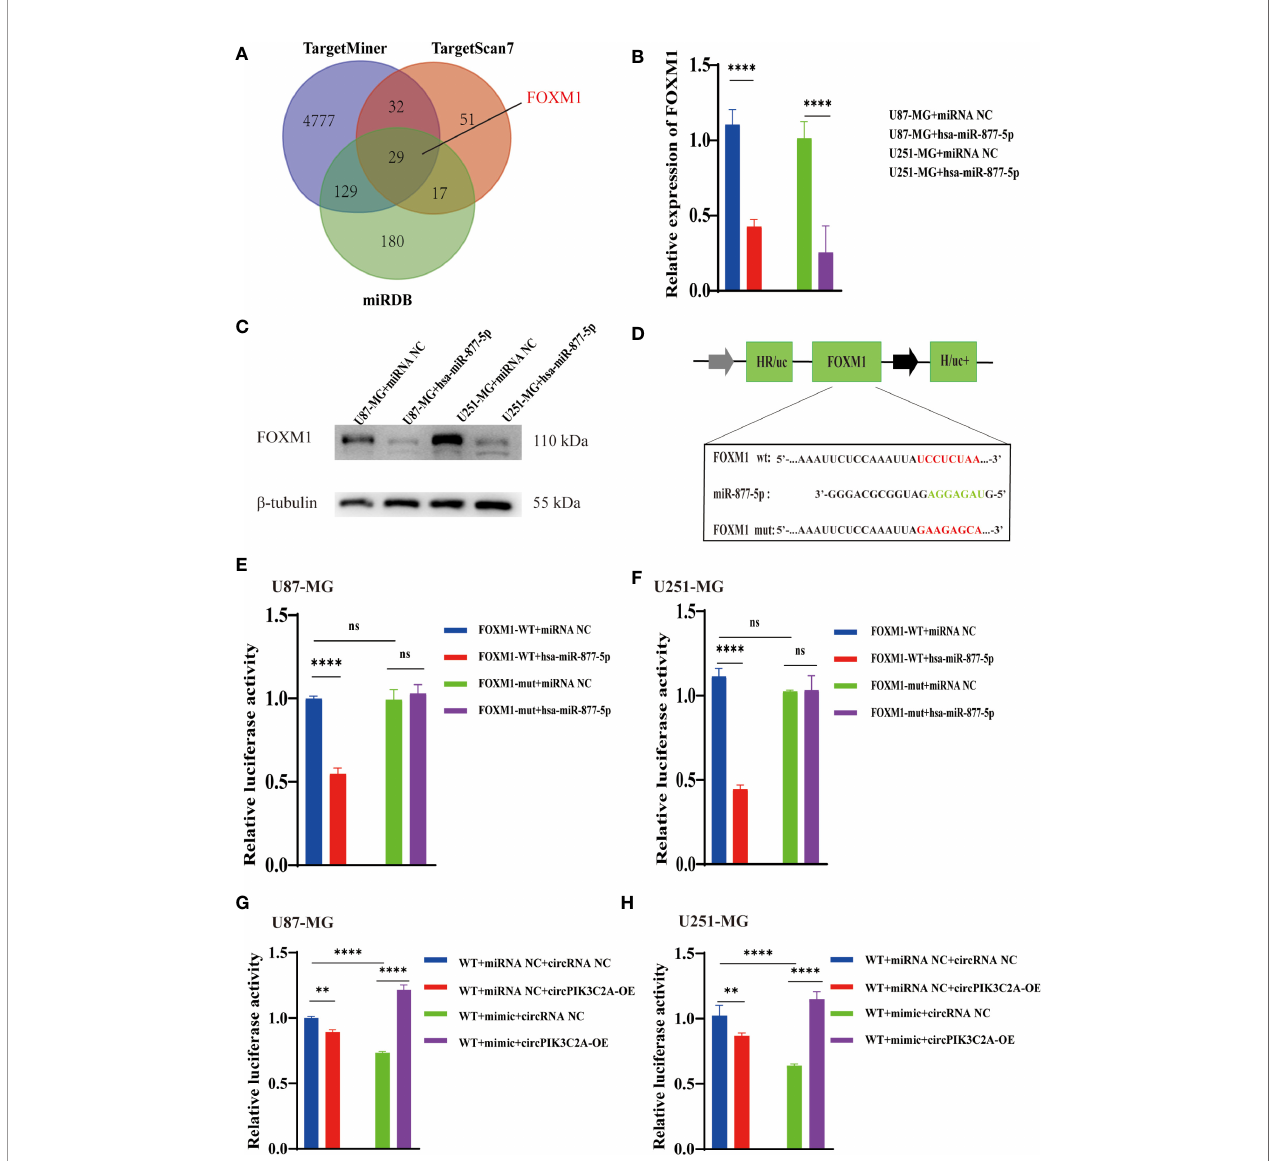
FIGURE 5 | CircPIK3C2A modulates the expression of FOXM1, an endogenous target of miR-1877-5p. (A) Binding region of FOXM1 with miR-877-5p as predicted by bioinformatics analysis. (B) After transfection of miR-NC or miR-877-5p mimics into U87-MG and U251-MG cells, the expression level of FOXM1 was analyzed using qRT-PCR. (C) After transfection of miR-NC or miR-877-5p inhibitors into A172 and T98 cells, the expression level of FOXM1 was analyzed using qRT-PCR (D) A schematic drawing of the screening procedure for miR-877-5p candidate targets. (E, F) A luciferase reporter plasmid carrying wildtype (WT) or mutant (MUT) FOXM1 was co-transfected into U87-MG and U251-MG cells with miR-877-5p mimics in parallel with an empty vector. (G, H) A luciferase reporter plasmid carrying wildtype (WT) FOXM1 was co-transfected into U87-MG and U251-MG cells with or without miR-877-5p mimics or circPIK3C2A-OE. Signi fi cant results are presented as ns P < 0.05, **P < 0.01, and ****P <